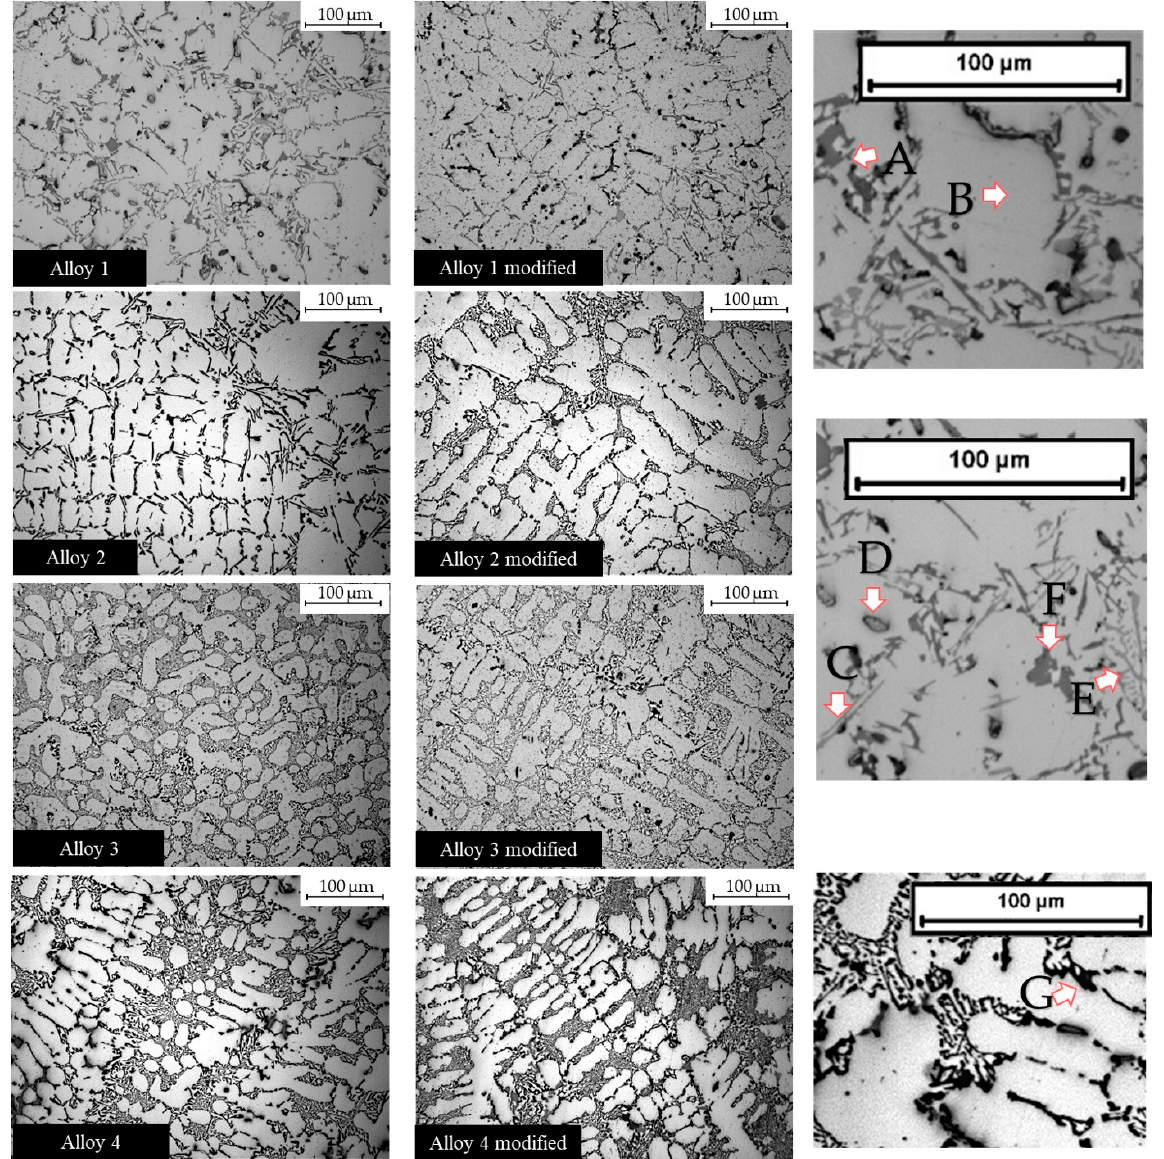
Figure 2. Optical microscope images at 20X magnification. Intermetallic phases that nucleated in the alloys. The arrows indicate some intermetallic phases. A: Eutectic silicon; B: α -aluminum matrix; C: acicular Fe intermetallic; D: Cu-based phase; E: Chinese script; F: Q-phase; G: Mg 2 Si.